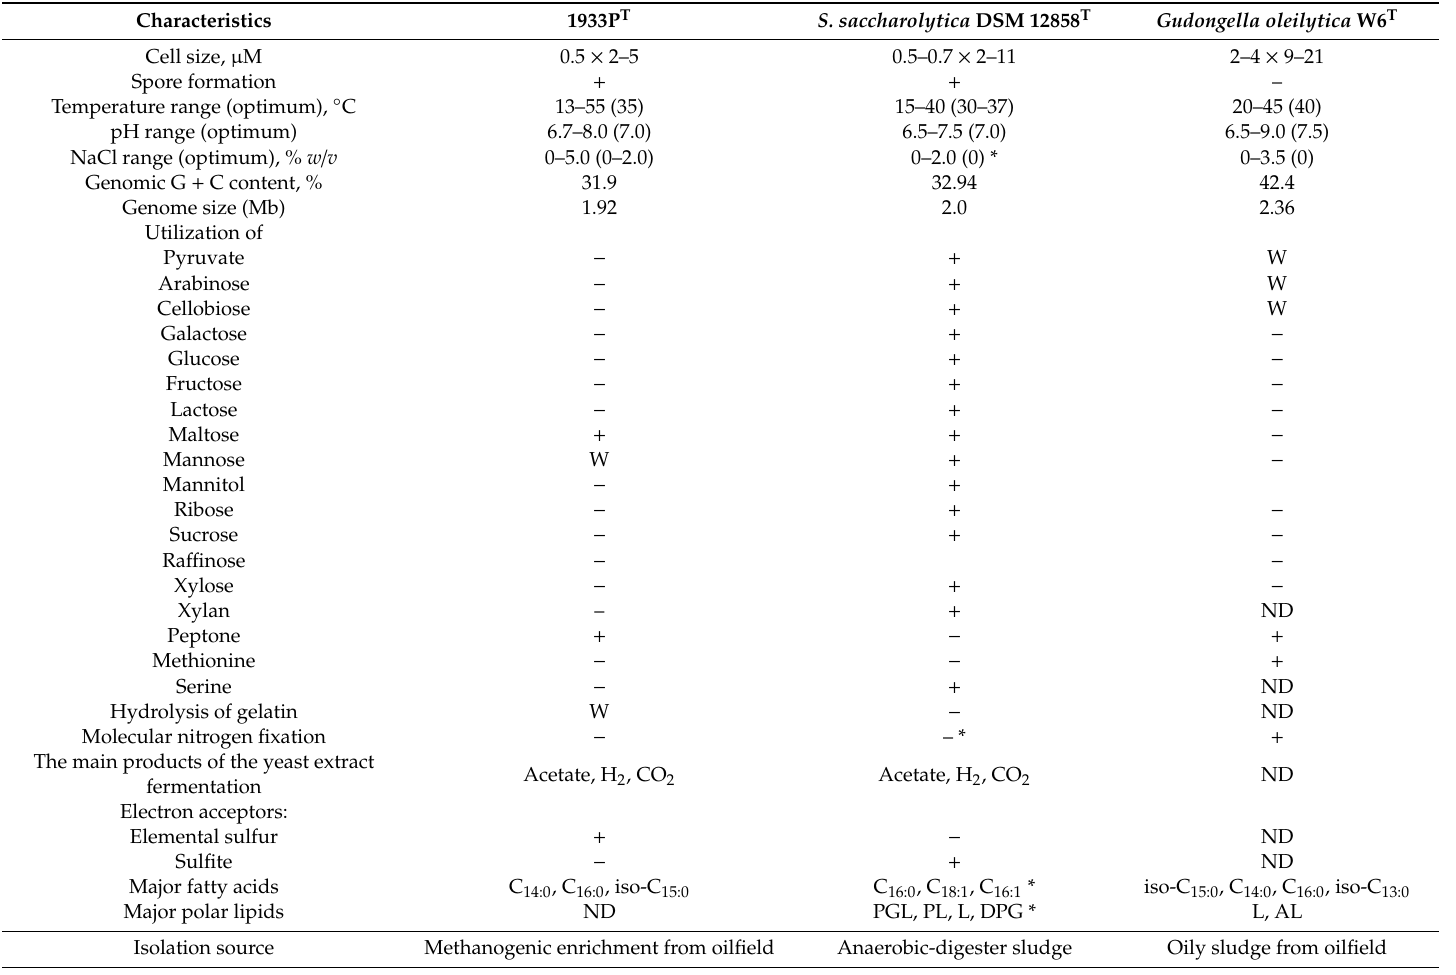
Table 1. Characteristics di ff erentiating strain 1933P T , S. saccharolytica DSM 12858 T [3] *, and Gudongella oleilytica